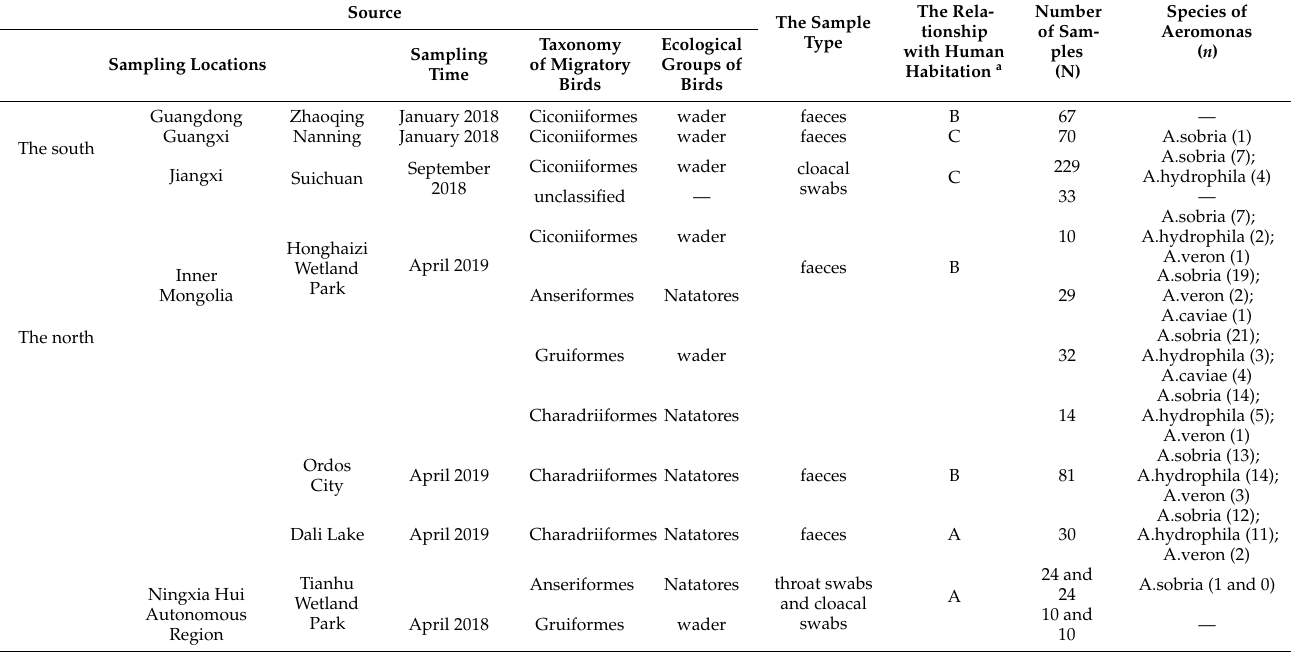
Table 3. Sample collection and Aeromonas isolation.